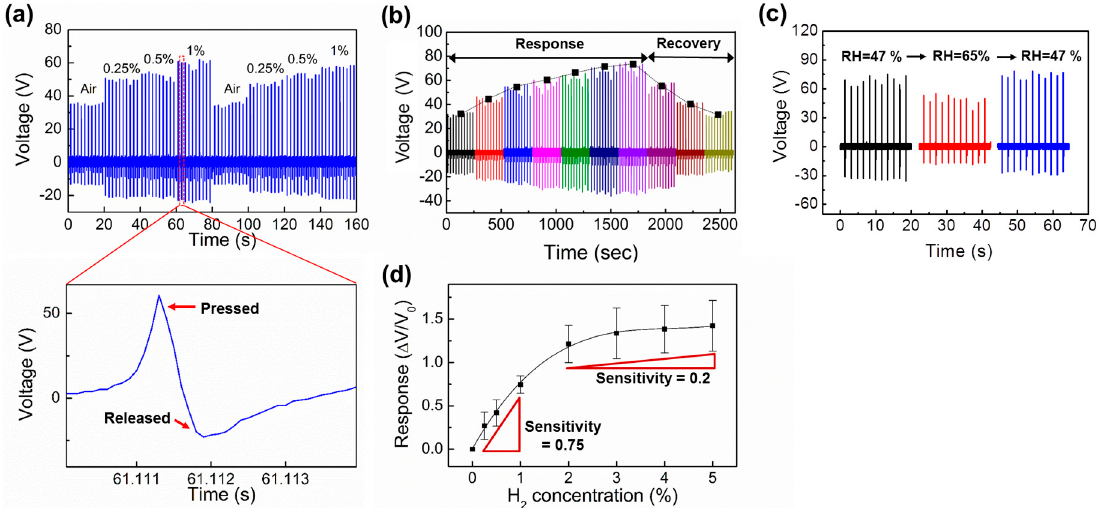
Figure 4. ( a ) Reproducible sensor responses. Similar outputs are repeatedly measured when the sensor is repeatedly exposed to H 2 ; ( b ) Sensor response and recovery time under 1%